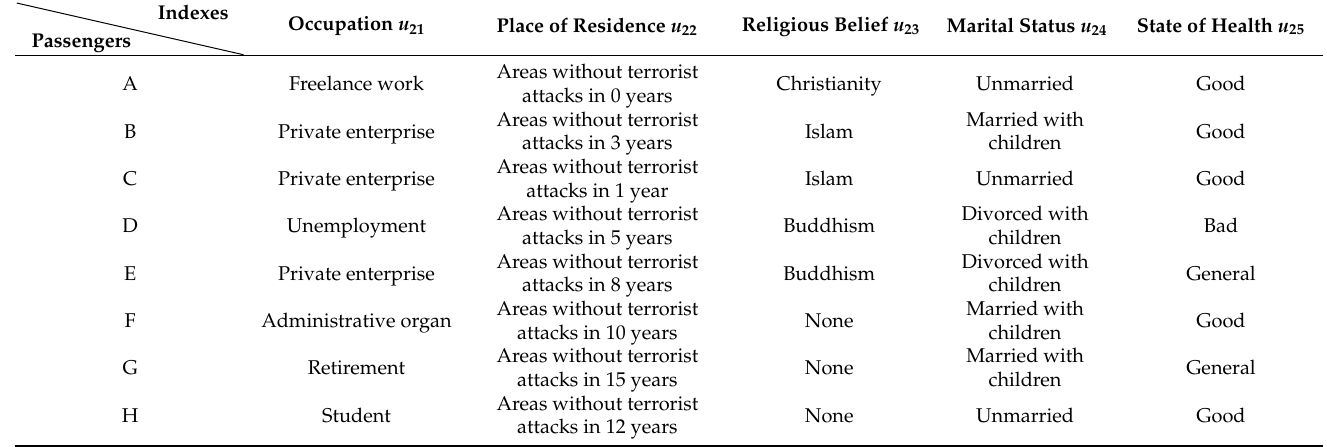
Table 15. Sample data of passengers (personal status indexes).